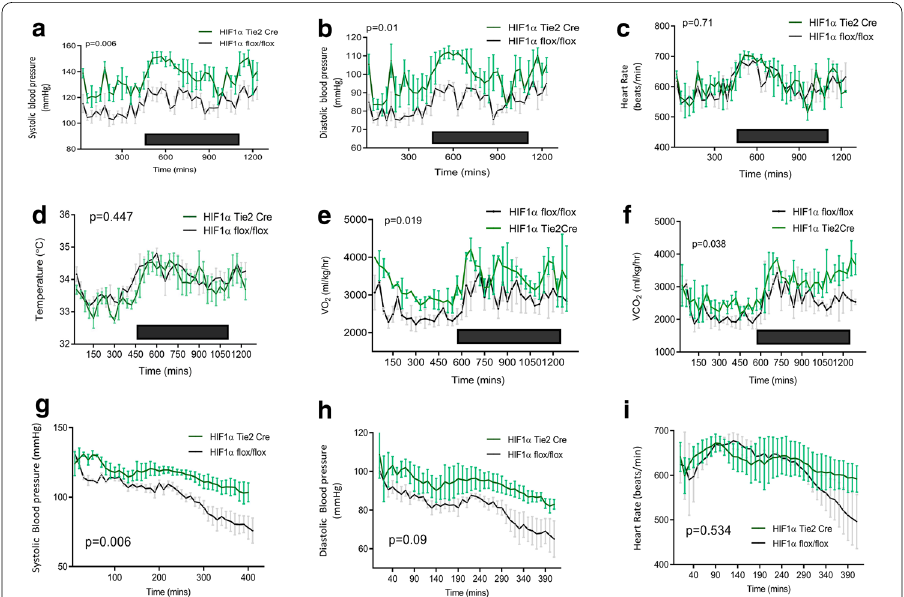
Fig. 1 Effects of HIF-1α pulmonary and systemic endothelial knockout on constitutive cardiovascular function. Circadian variations in a systolic, b diastolic blood pressure, c heart rate, d subcutaneous temperature, e oxygen consumption and f carbon dioxide synthesis of HIF-1α Tie2 Cre (green, n littermate HIF-1α flox/flox (grey, n 4) mice were recorded by radio-telemetry. Black box represents nocturnal = phase. Haemodynamic response to 10 mg/kg LPS bolus in HIF-1α Tie2 Cre (green, n HIF-1α flox/flox (grey, n 3) mice on g systolic and H: diastolic blood pressures and i heart rate are displayed. = Data are presented as a mean SEM for each 30 min period, p values for area under the curve followed by ± unpaired t test are